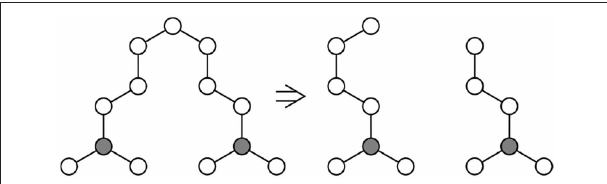
FIGURE 5 | Consider part of a network containing only chains of length n , with v chains connected to a single gray atom (Left) . One possible bond-breaking event would convert one of these chains into two chains of length ∼ n / 2 (Right) , increasing the entropy of the